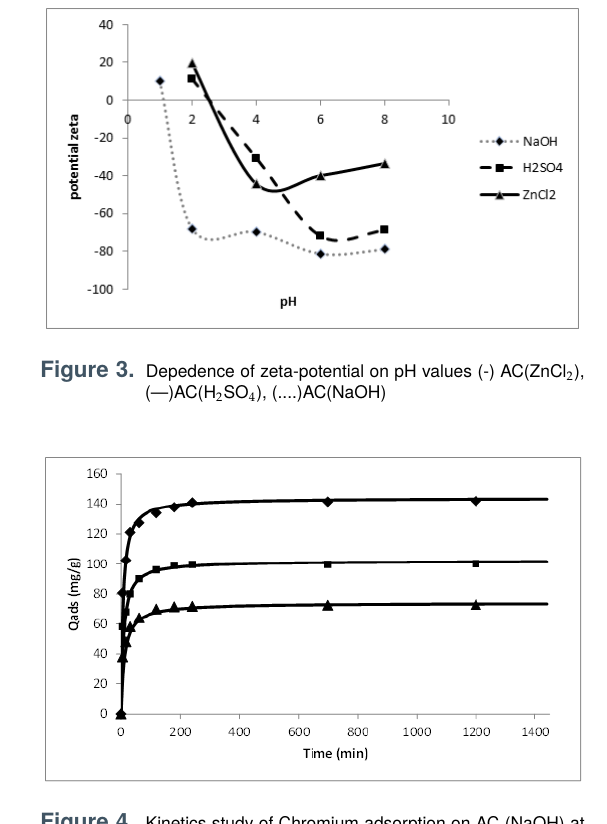
Figure 4. Kinetics study of Chromium adsorption on AC (NaOH) at different concentrations ( (cid:31) ): 500 mg/l, ( (cid:30) ) 250 mg/l and ( (cid:29) ) 100 mg/l.